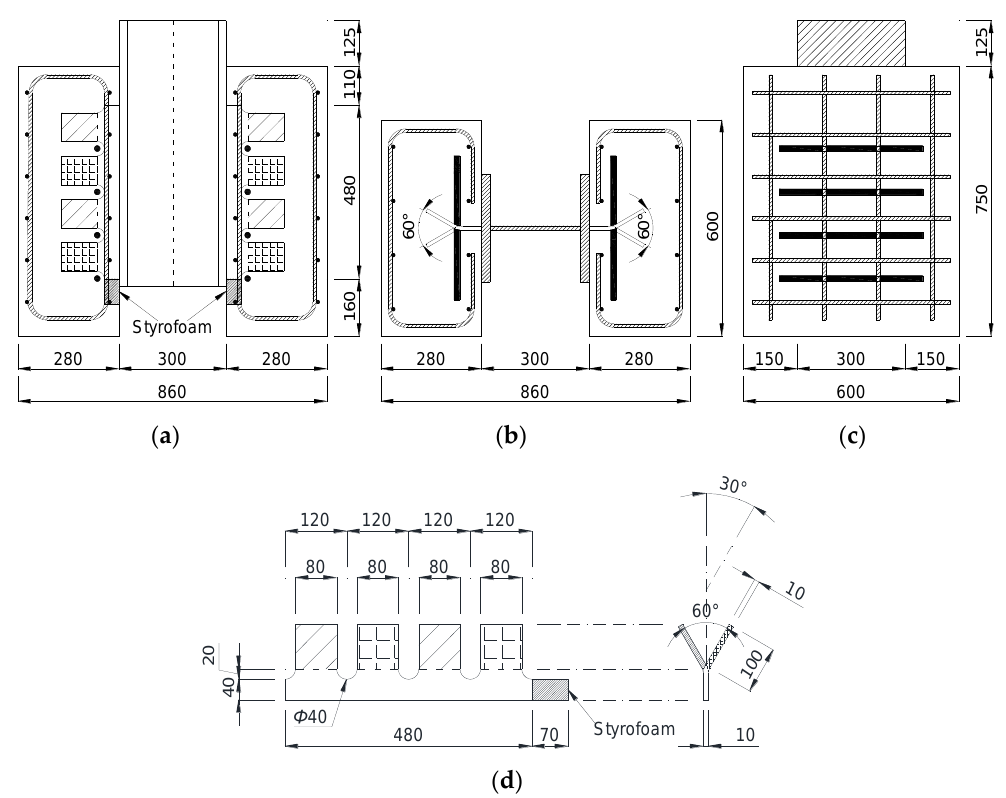
Figure 1. Dimensions of the push-out specimen with the Y-type perfobond rib shear connector: ( a ) Front view, ( b ) plan view, ( c ) side view. ( d ) Details of the Y-type perfobond rib shear connector. Table 3. Concrete compressive strength.